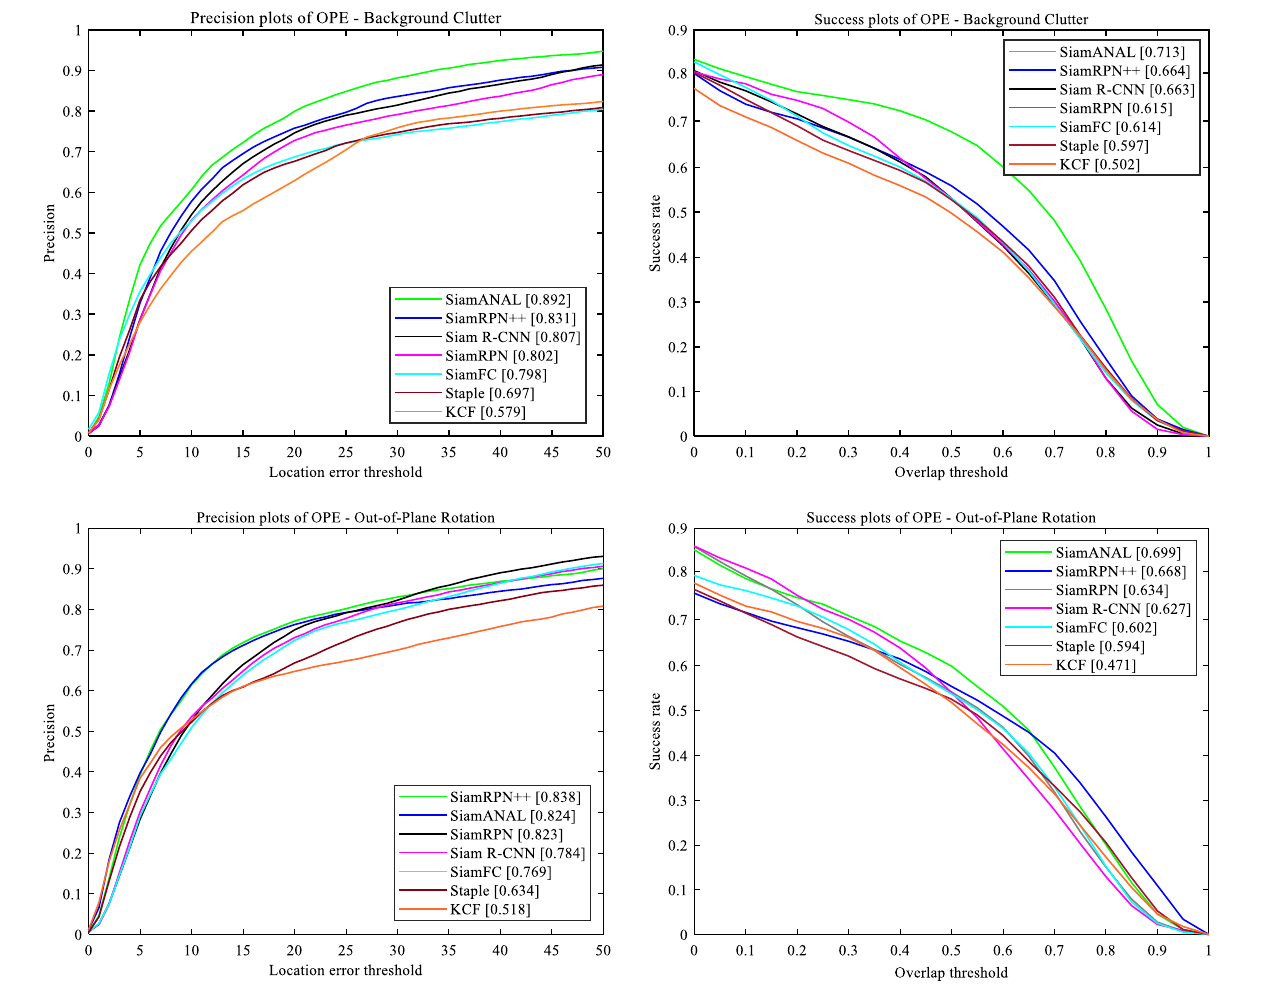
Fig. 8 Comparison of different algorithms with different video attributes